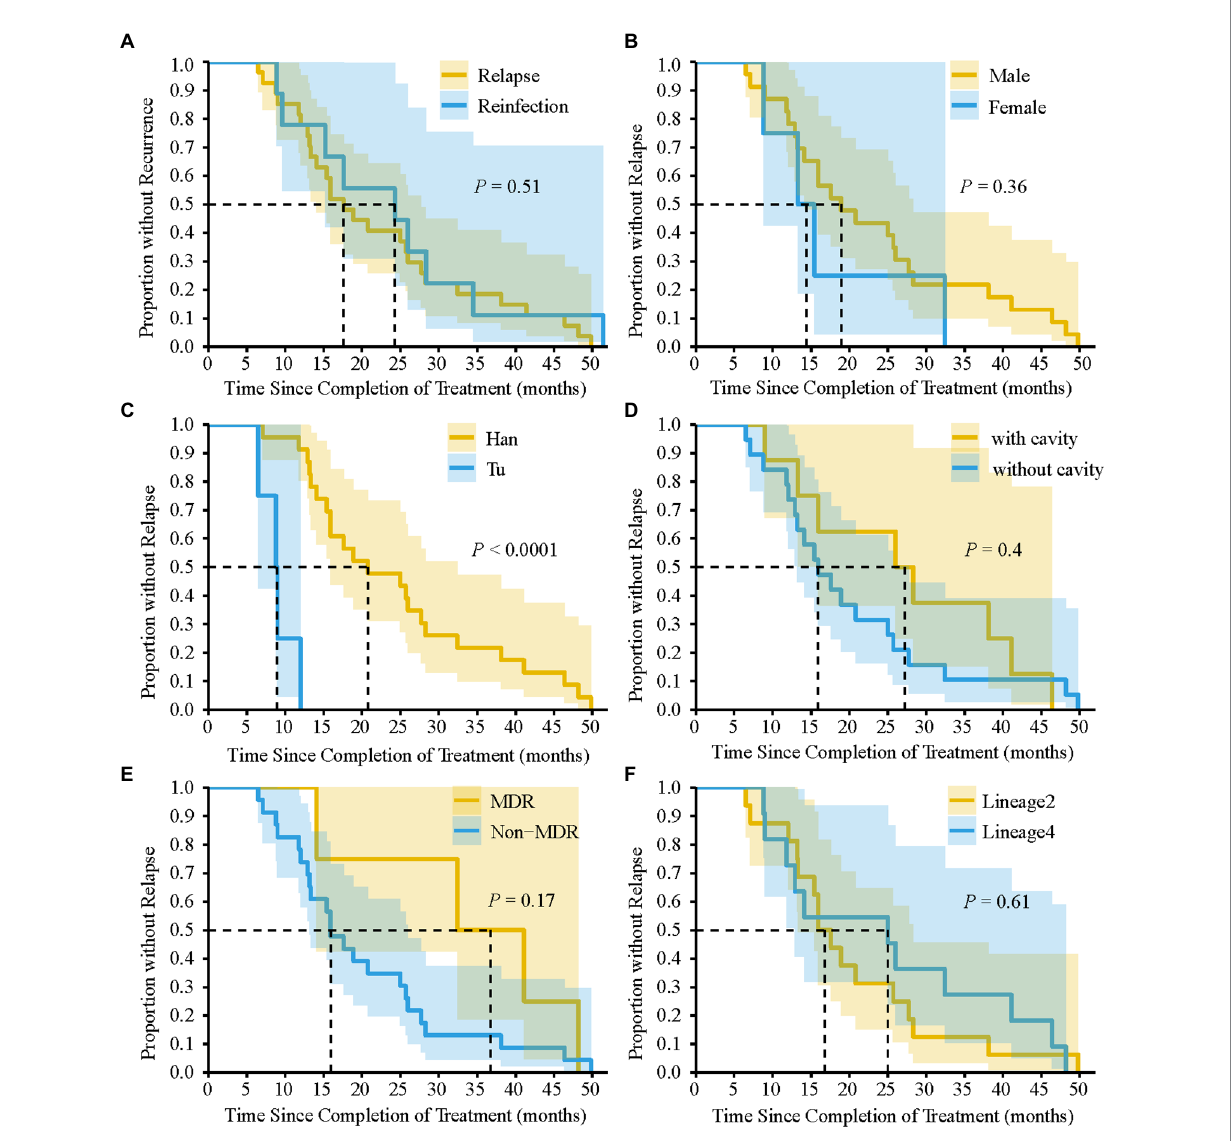
FIGURE 4 Kaplan–Meier survival estimates for TB recurrence. Comparison of the time interval required for relapse and reinfection (A) . The time interval required for relapse to occur by gender (B) , nationality (C) , pulmonary cavity (D) , MDR-TB (E) , and Lineage of TB strains (F) . dashed line indicate that the time interval required for 50% of TB recurrence or relapse to occur. p -value was calculated by Log-rank